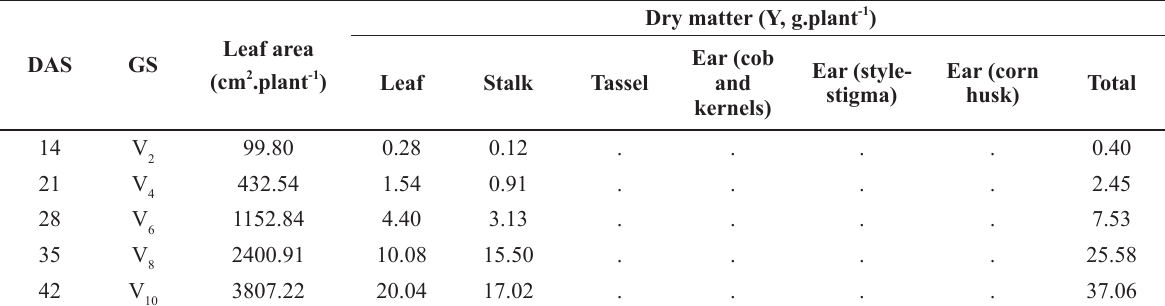
leaf area (la, cm 2 .plant -1 ) and dry matter (g.plant -1 ) for leaf, stalk, tassel, ear (cob and kernels, style-stigma and corn husk) and total in relation to days after sowing (Das) and growth stage (Gs) of the maize crop (hybrid DKb 390 pro 2). piracicaba (sp), brazil.